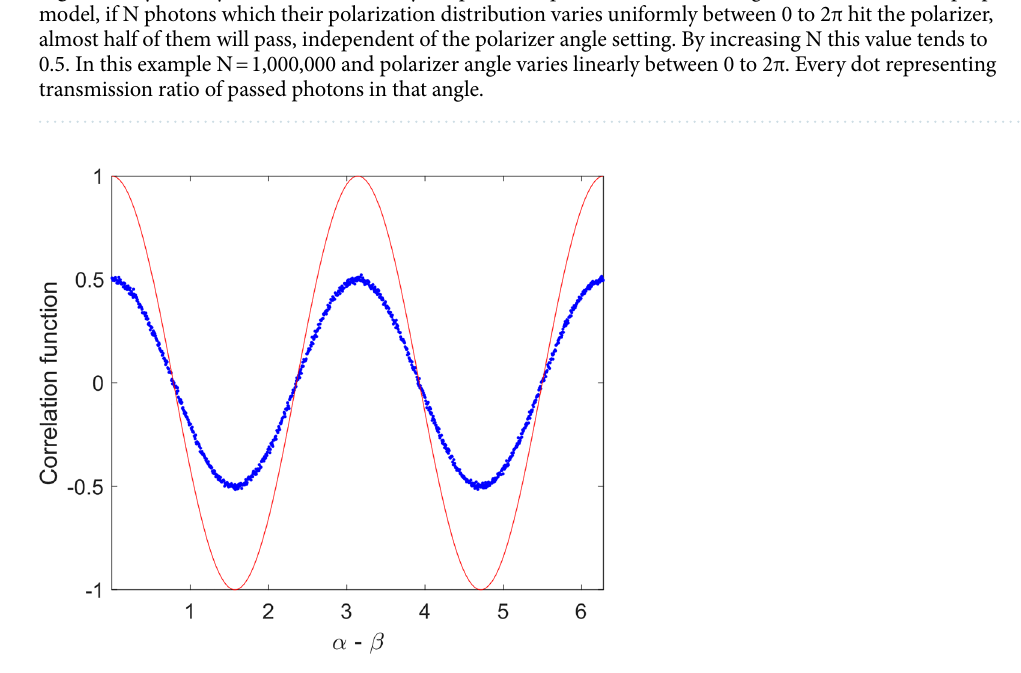
Figure 4. Simulation result of correlation function versus angle difference of polarizers based on relation (15) (dot line-blue) compared to quantum mechanics prediction (solid